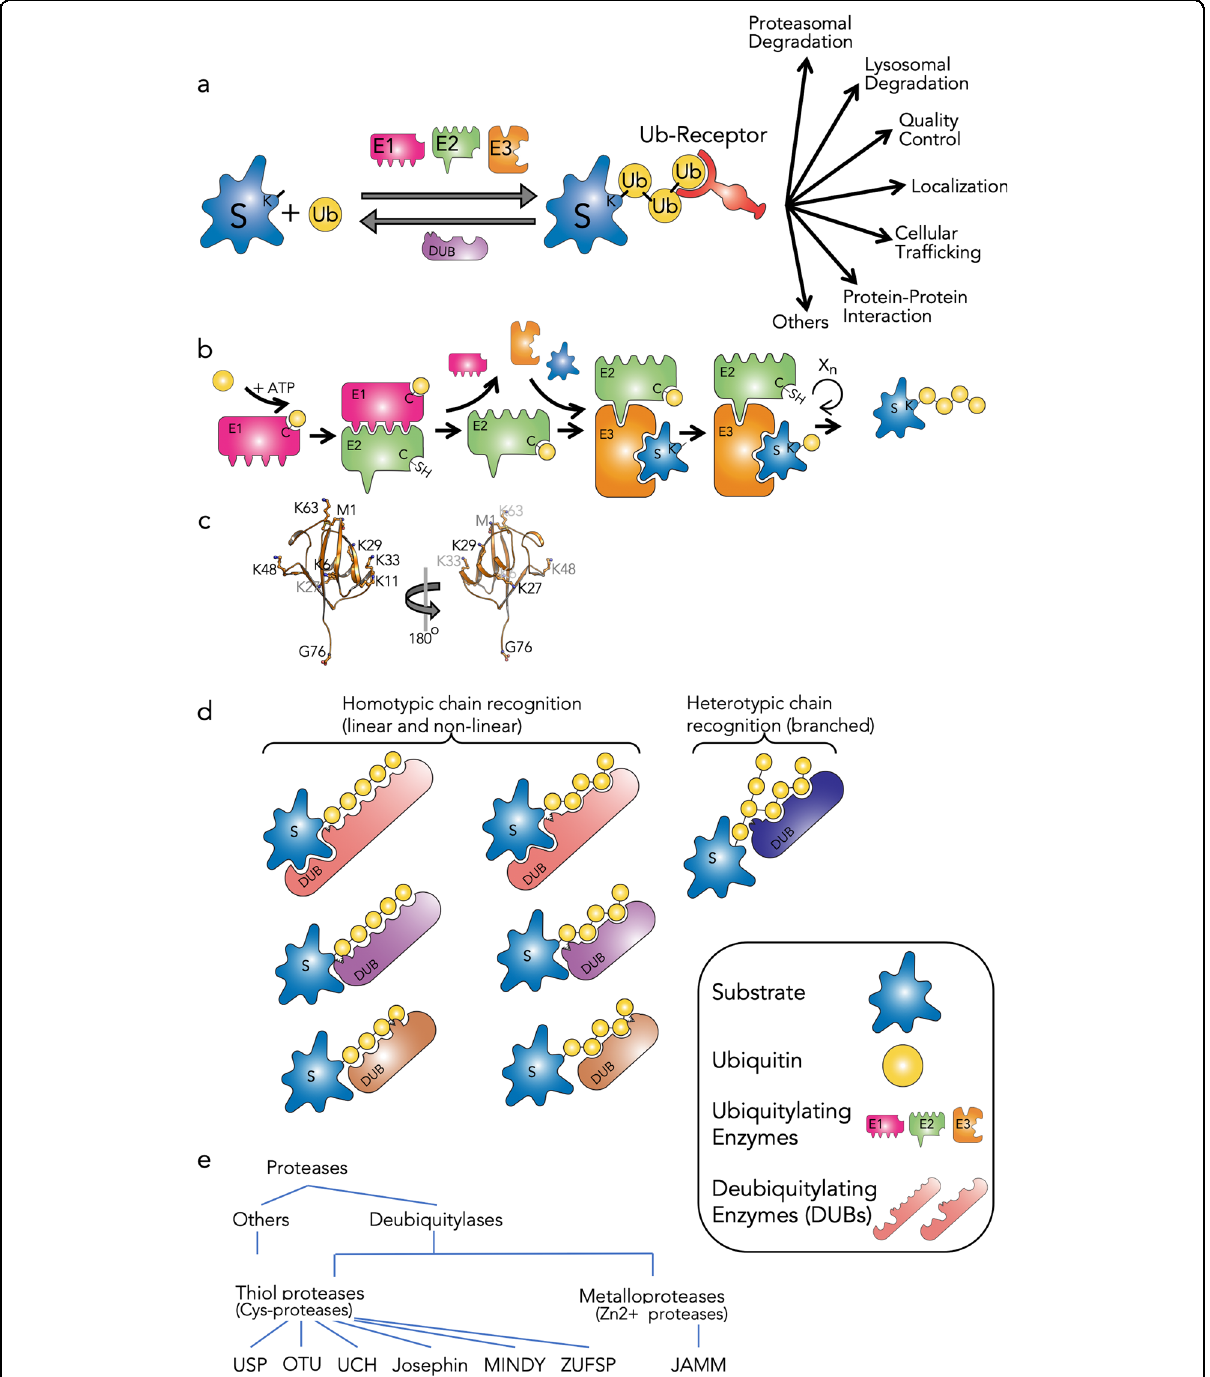
Fig. 1 The ubiquitin system: ubiquitylation, ubiquitin recognition, and deubiquitylation. a A schematic representation of ubiquitylation/ deubiquitylation events of target proteins and the cellular outcome. b The ubiquitylation cascade by three types of enzyme: ubiquitin-activating enzyme (E1), ubiquitin-conjugating enzyme (E2), and ubiquitin ligase (E3). c The seven lysine residues and the N-terminal methionine (M1) are projected on the structure of ubiquitin (PDB code 1UBQ 98 ). d Principles of substrate recognition and ubiquitin cleavage by DUBs. e . Families of DUBs classi fi ed by sequence homology of their catalytic